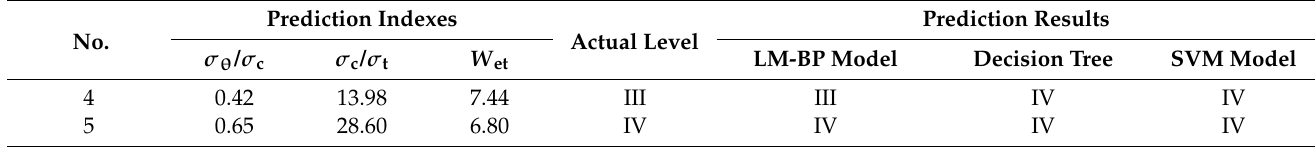
Table 9. Prediction results of 4 # and 5 # cases.